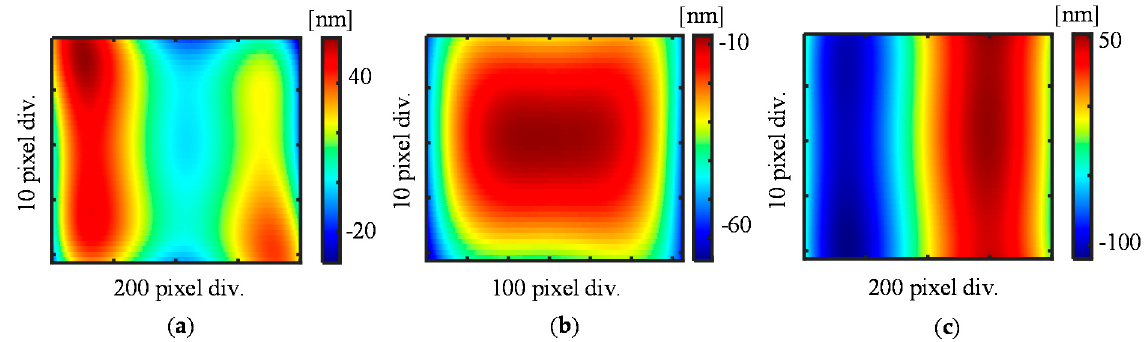
Figure 5. Simulation results of the form errors of a linear scale. ( a ) Out-of-flatness error; ( b ) Reference flat error; ( c ) X - directional pitch deviation.